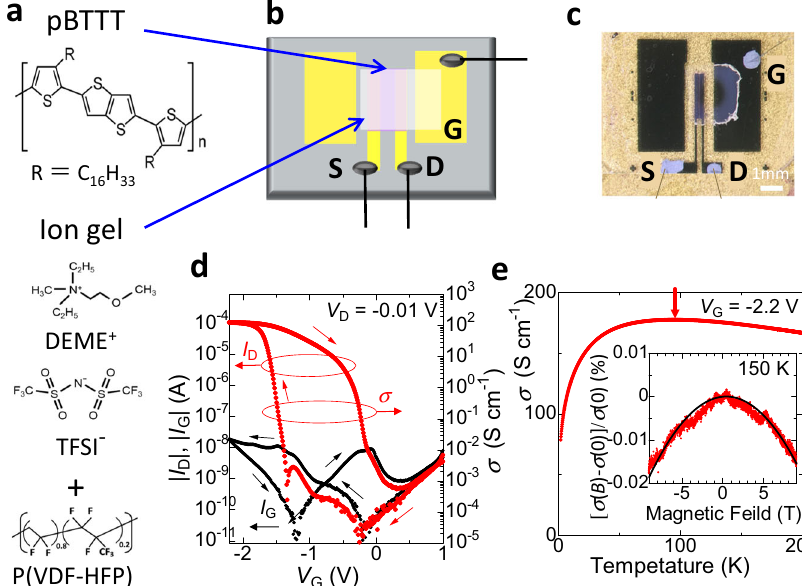
Fig. 1 Conductivity and magnetoconductance measurements by using the ionic-liquid-gated thin- fi lm transistor structure. a Chemical structures of poly (2,5 bis (3-hexadecylthiophene-2-yl)thieno[3,2-b]thiophene) (pBTTT) and constituents of the ion gel, N,N-diethyl-N-methyl-N-(2-methoxymethyl) ammonium (DEME), bis(tri fl uoromethanesulfonyl)imide (TFSI) and poly(vinylidene fl uoride-co-hexa fl uopropylene) [p(VDF-HFP)]. b Schematic device structure of the ion gel-gated transistor with a side-gate structure. Here, G, S, and D denote gate, source, and drain electrodes, respectively. c Photograph of a typical device shown with a 1-mm scale. d Transfer characteristics and gate current of the device operated at room temperature. Here, I D , I G , V G , and V D represent the drain current, gate current, gate voltage, and drain voltage, respectively. The source electrode is grounded. e Temperature of conductivity σ at gate voltage V G = − 2.2 V. Inset: effectively metallic magnetoconductance [ σ ( B ) − σ (0)]/ σ (0) observed at V G = − 2.2 V at 150 K. The solid curve shows the fi tting of the experimental data by a quadratic relation of the magnetic fi